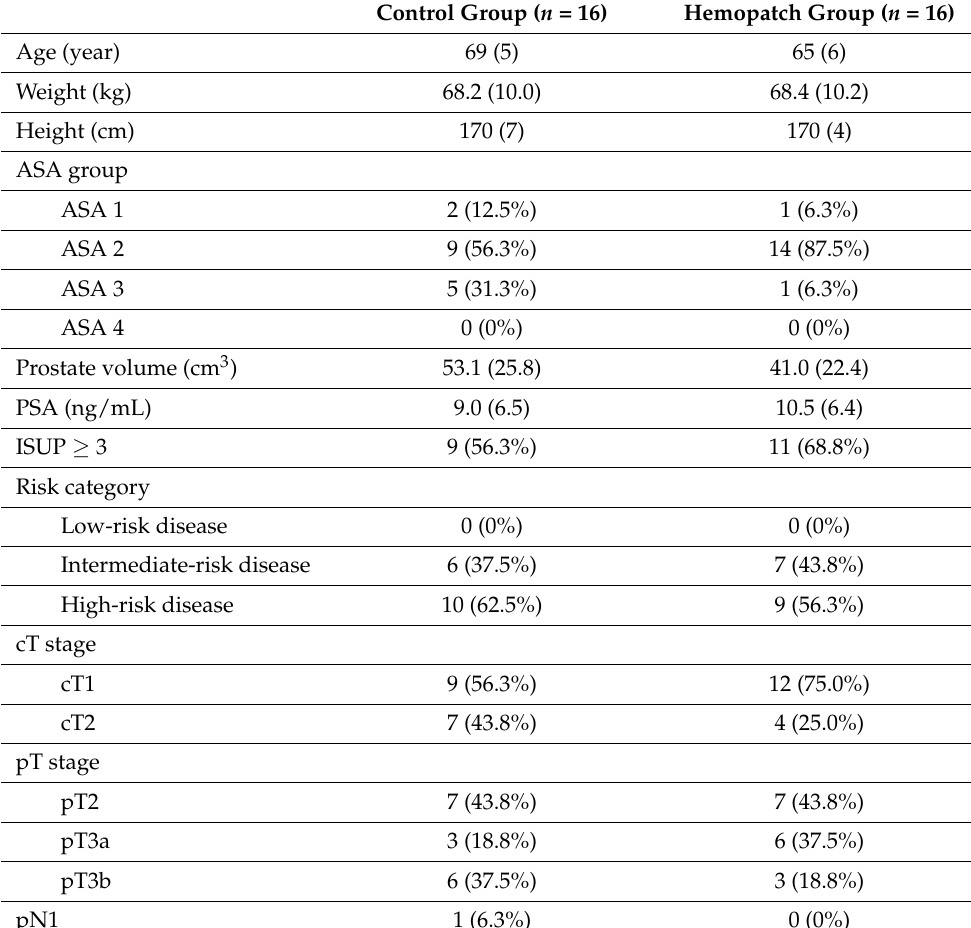
Table 1. Baseline demographic and clinical